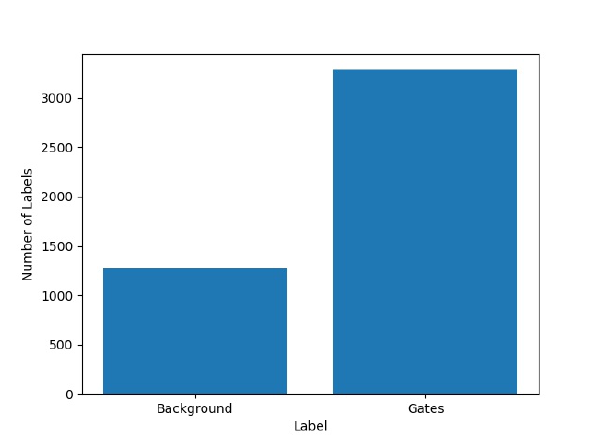
Figure 8. Distribution of labels in 9106 images: background, 2534 labels; gates, 6572